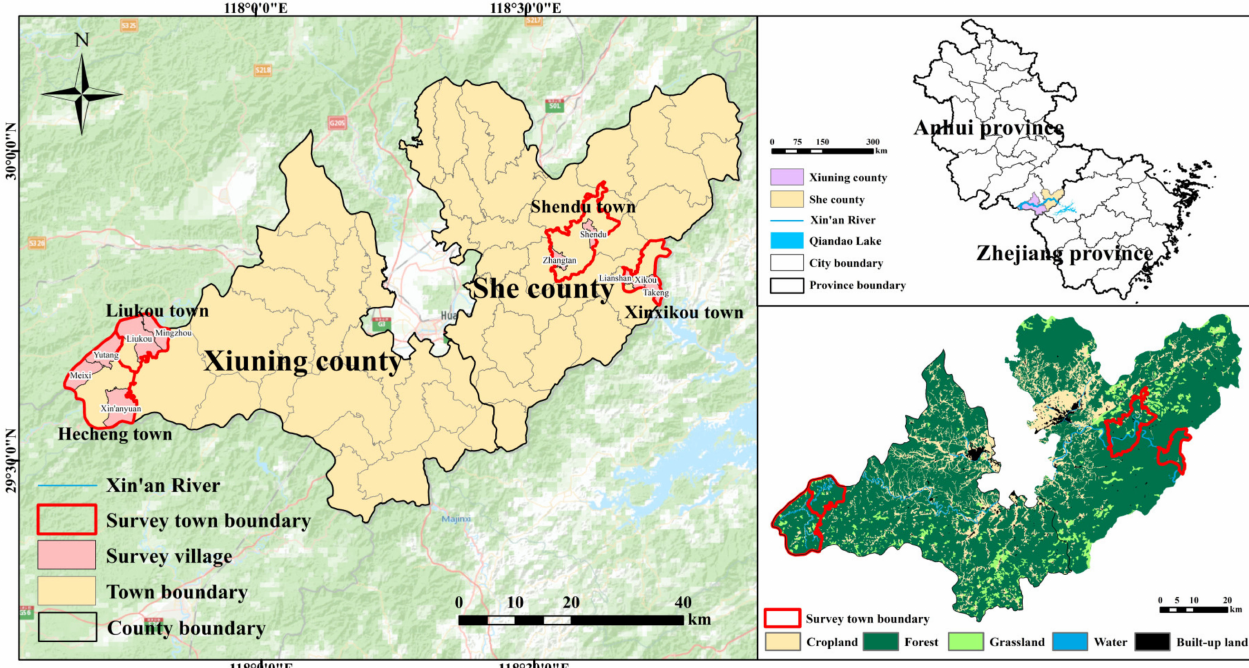
Figure 2. Study area and sample